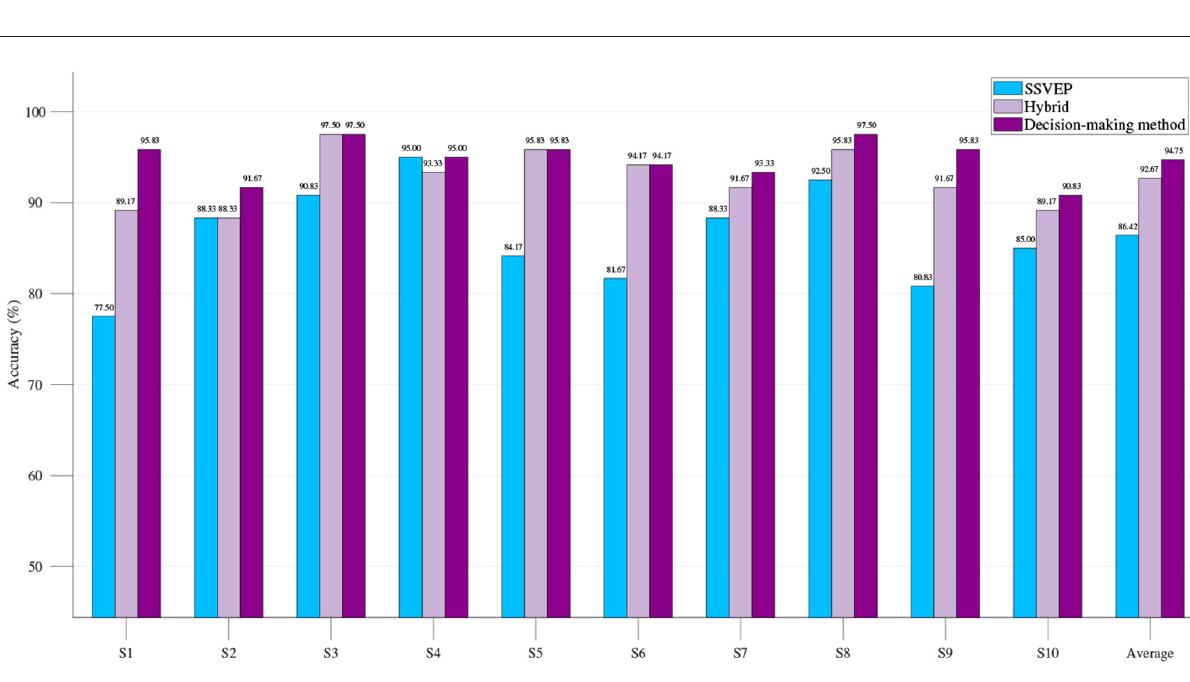
and hybrid BCI system. It can be found that compared with the single-modality system, the ITR of the hybrid BCI system increases and the accurate classification rate improves, while the decision-making method based on SSVEP and EOG proposed in this paper can further improve the performance of the hybrid BCI system (Figure